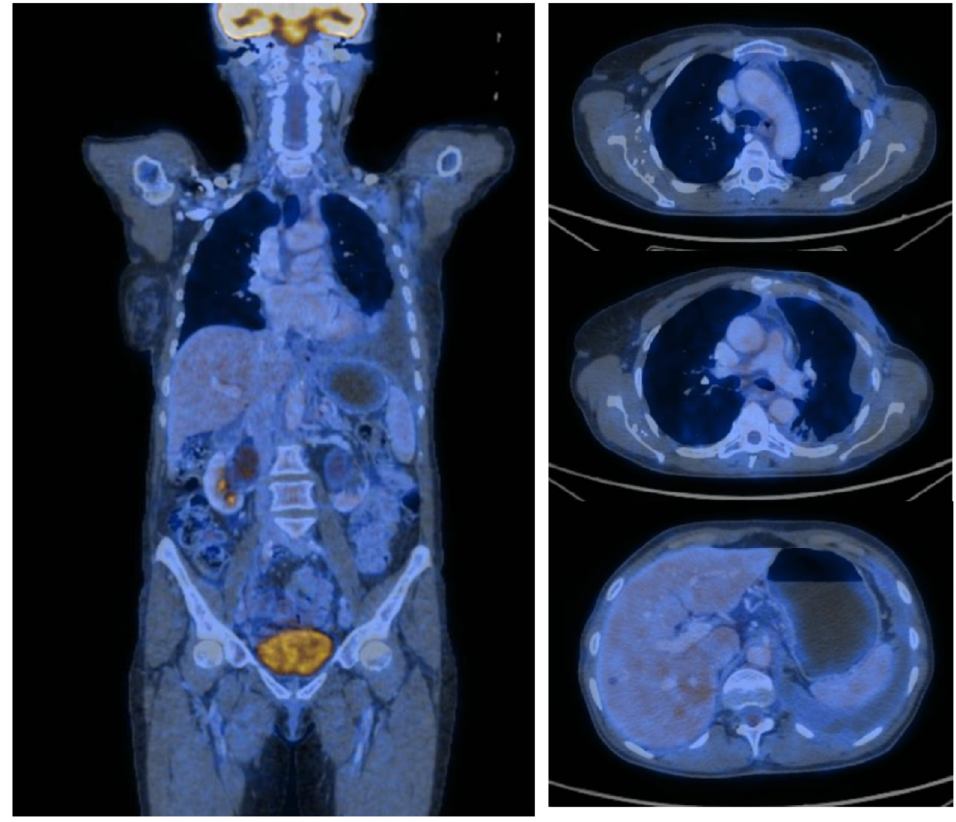
Figure 3. PET-CT from June 2021 with no metabolically active lesions.